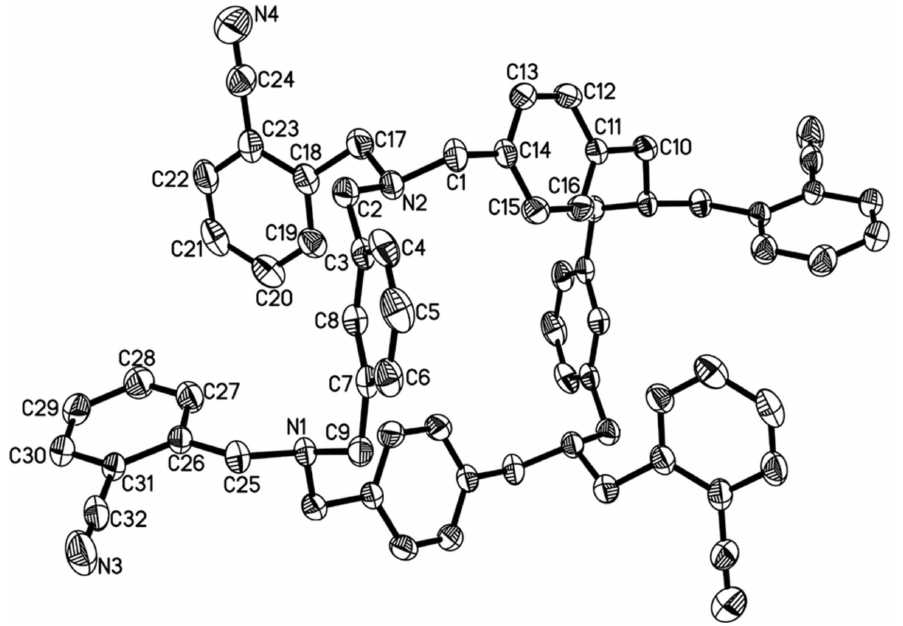
Figure 1 Molecular structure of (I). Displacement ellipsoids are drawn at the 30% probability level and H atoms are omitted for clarity. The unlablled atoms are related by - x +1, - y +1, - z